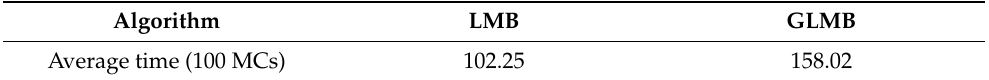
Table 2. Comparison of the time spent in the experiments with the LMB and GLMB algorithms.